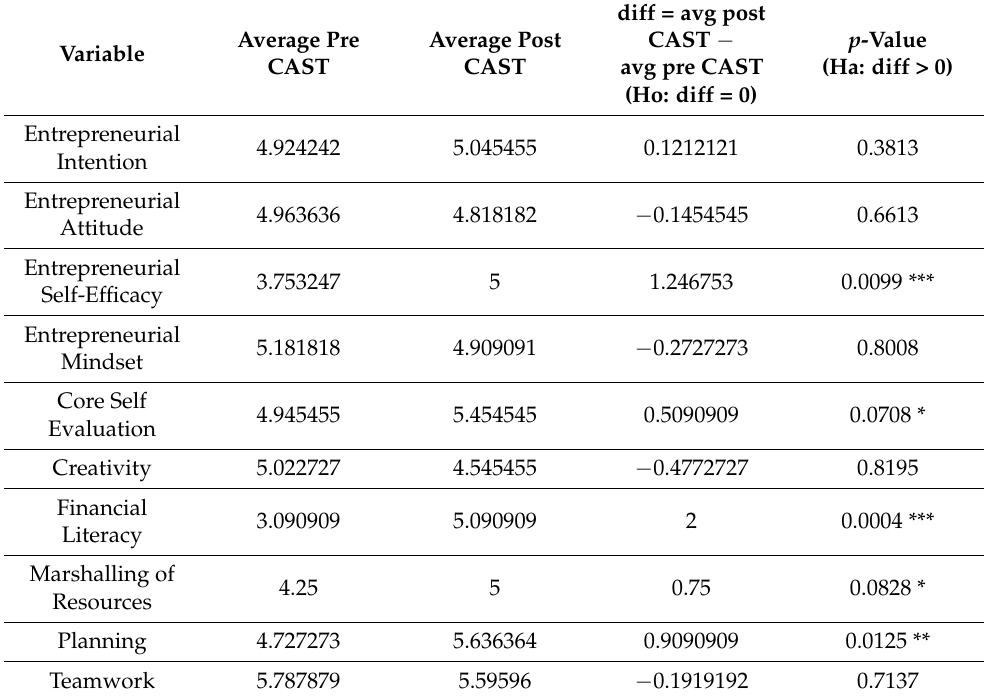
Table A5. Output of t -tests on the entrepreneurial characteristics, pre- and post-course, of the PhD